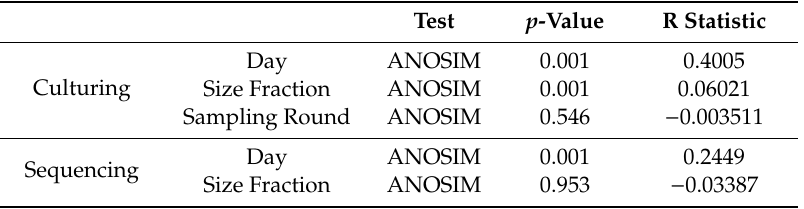
Table 2. Analysis of similarity (ANOSIM) permutational analyses of the culturable airborne fungal communities observed over different sampling days and size fractions using Jaccard distance measurements. P -values which are significant ( p < 0.05) are written in bold. R-statistic values close to 1.0 suggest high dissimilarity between groups, while an R-statistic value close to 0.0 suggests no systematic differences between groups.